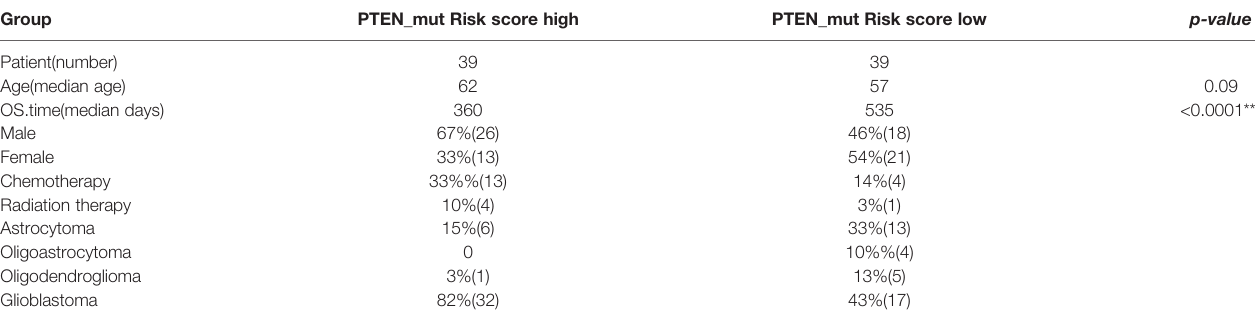
TABLE 3 | Clinical information about risk high and risk low patients in PTEN-mut subgroups (*** signi fi cant difference).